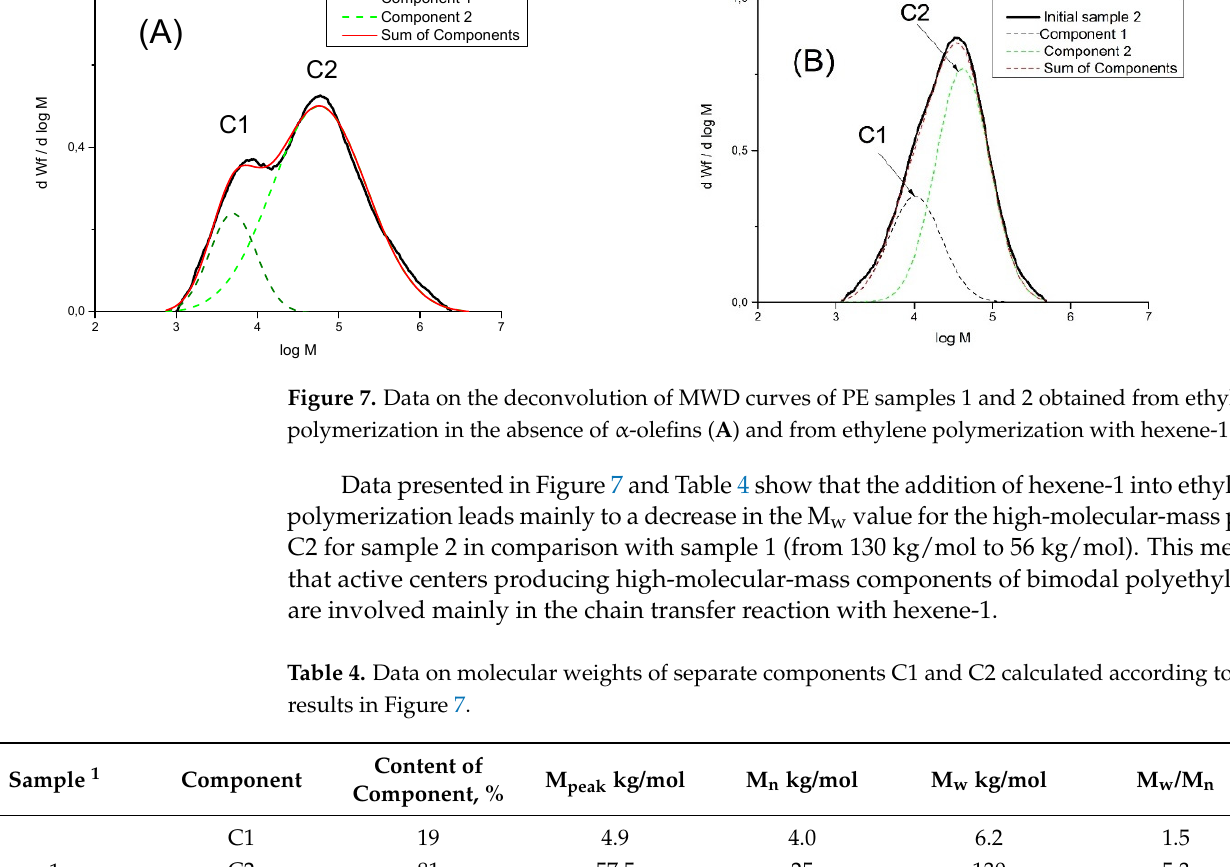
Figure 6. MWD curves for polymer samples obtained during ethylene polymerization in the presence of hexene-1 ( A , curve 2), butene-1 ( B , curve 3), propylene ( C , curve 4) and in the absence of α -olefins (curve 1 in A – D ); ( D )—MWD curves for all polymers obtained in exps. 1–4 (Table 3).